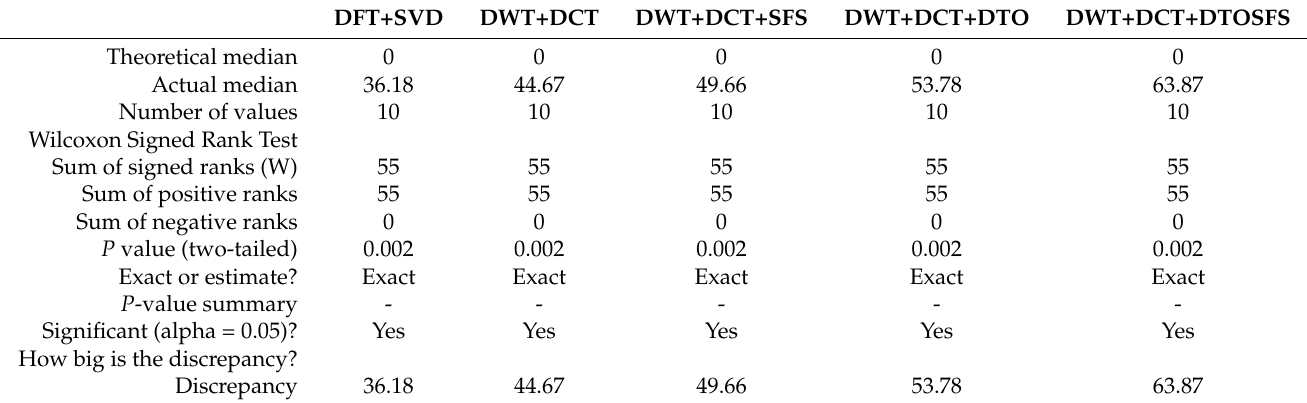
Table 4. Evaluation of the Wilcoxon signed rank test based on the recorded